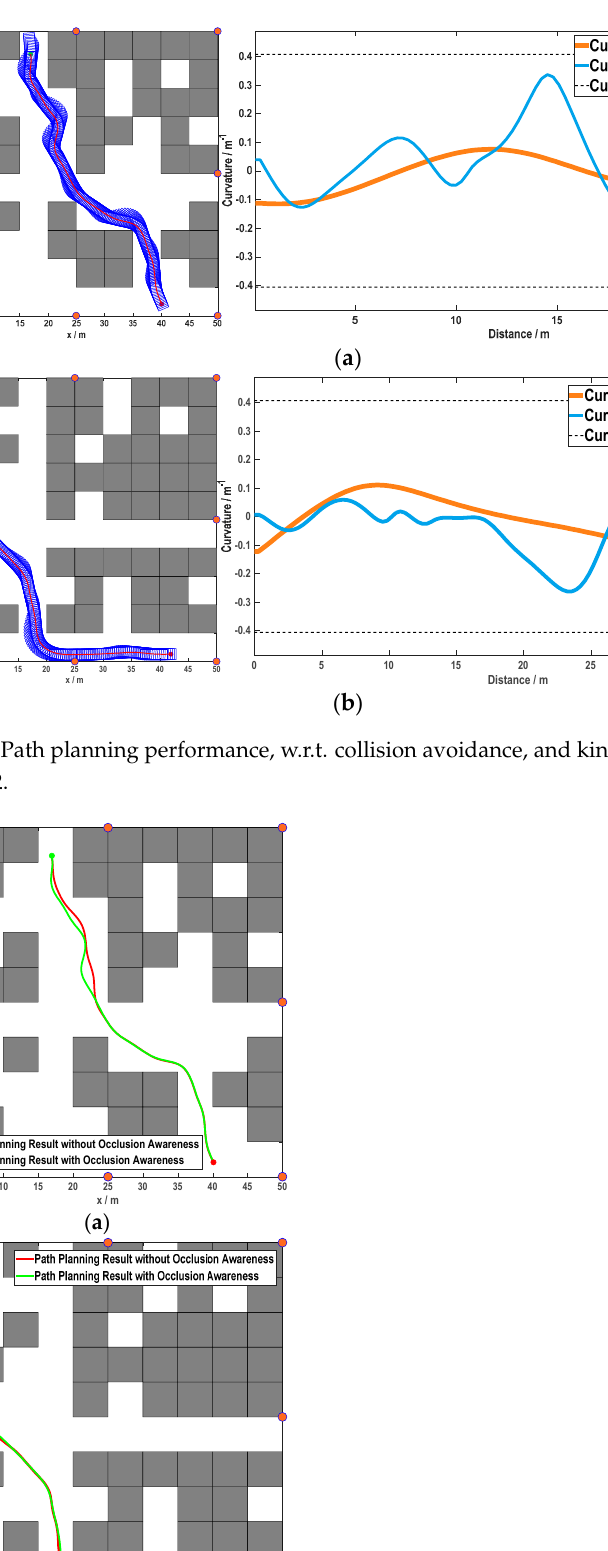
Figure 8. Path planning results of typical simulation cases in side view and bird-eye view: ( a ) Case 1; ( b ) Case 2 (zoom in to see more clearly).